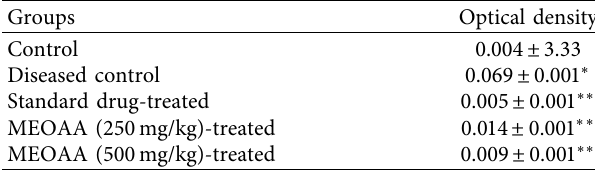
Table 2: Effect of A. arvensis on vesical vascular